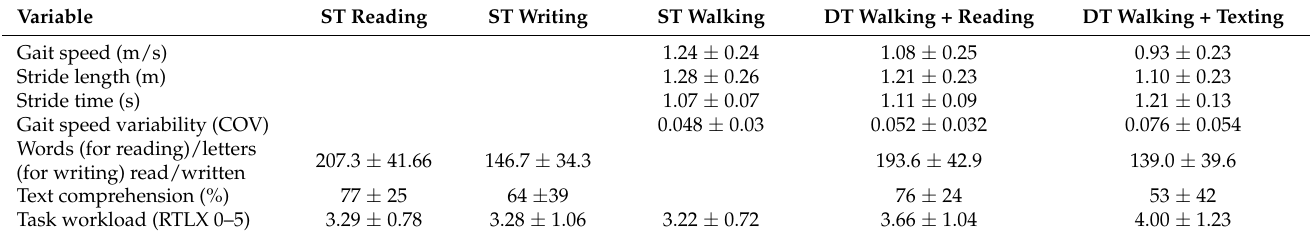
Table 2. Outcomes for walking and reading or writing for single- and dual-task trials. ST = single task, DT = dual task. Variable